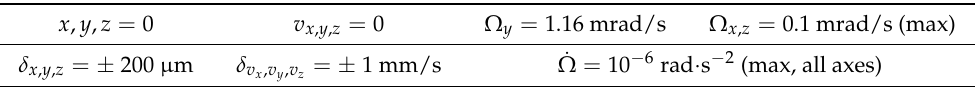
Table 5. Assumptions on CAI atomic source parameters and satellite rotation parameters. δ i refers to the amplitude of variation impacting parameter i